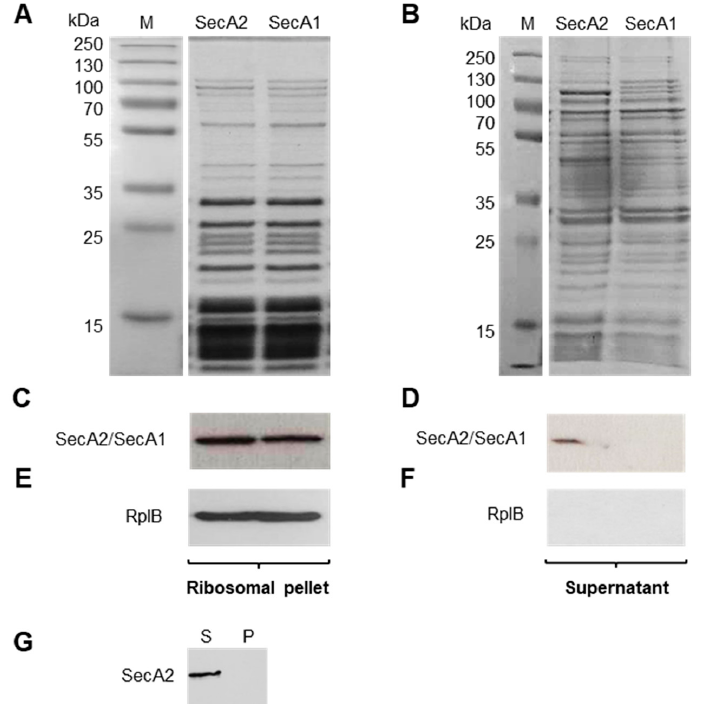
Figure 3. Co-sedimentation experiments of SecA2 with ribosomes. Purified SecA2 and SecA1 proteins (1 µM) were mixed with purified ribosomes (4 µM) and sedimented by sucrose cushion ultracentrifugation. Coomassie stained gel of ribosomal pellet ( A ) and the corresponding supernatant ( B ) are depicted. Western blot analyses were used to detect SecA2 and SecA1 in the ribosomal pellet ( C ) and in the supernatant ( D ); ( E , F ) detection of the ribosomal protein RplB in the ribosomal pellet and the supernatant; and ( G ) SecA2 sedimentation in the pellet (P) and supernatant (S) fractions in the absence of ribosomes.